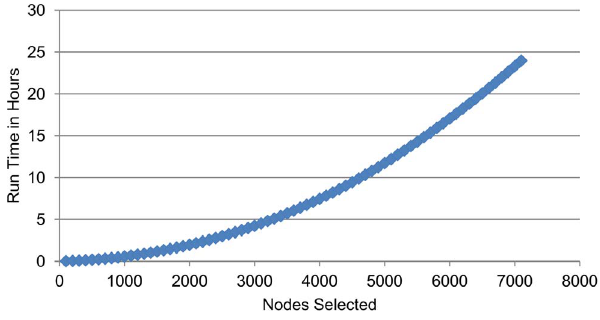
Figure 4. Run Time of GREEDY- C LC 2 on the Douban Social Network. The run time in hours for GREEDY- C LC 2 to build sets between 100 and 7100 nodes.